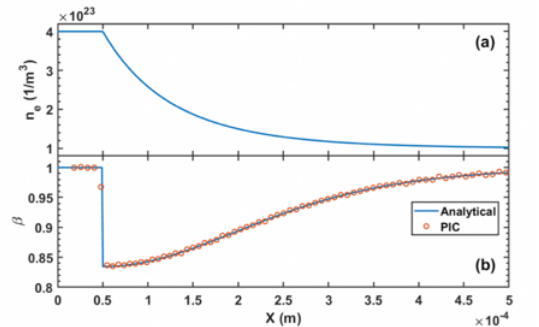
Figure 4. PIC simulation of plasma mirror acceleration [50]. ( a ) A plasma target with a constant-plus- exponential density gradient, n p ( x ) = n p 0 ( 1 + e − x / D ) 2 , n p ( x = 0 ) = 1.0 × 10 17 cm − 3 . ( b ) Compar- ison of the plasma mirror speed, β = ˙ x M / c , between the analytic formula (solid blue curve) and the PIC simulations (orange circles). The two agree extremely well. Note that the convention of the laser propagation direction in this PIC simulation is from left to right, which is opposite to that in the typical theoretical treatment of flying mirrors as analog black